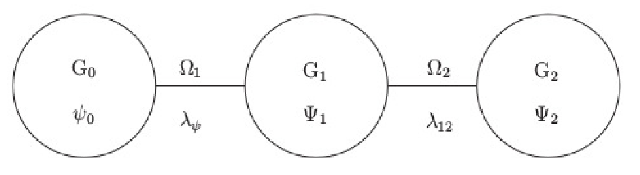
Figure 1 . Moose diagram of the three-site